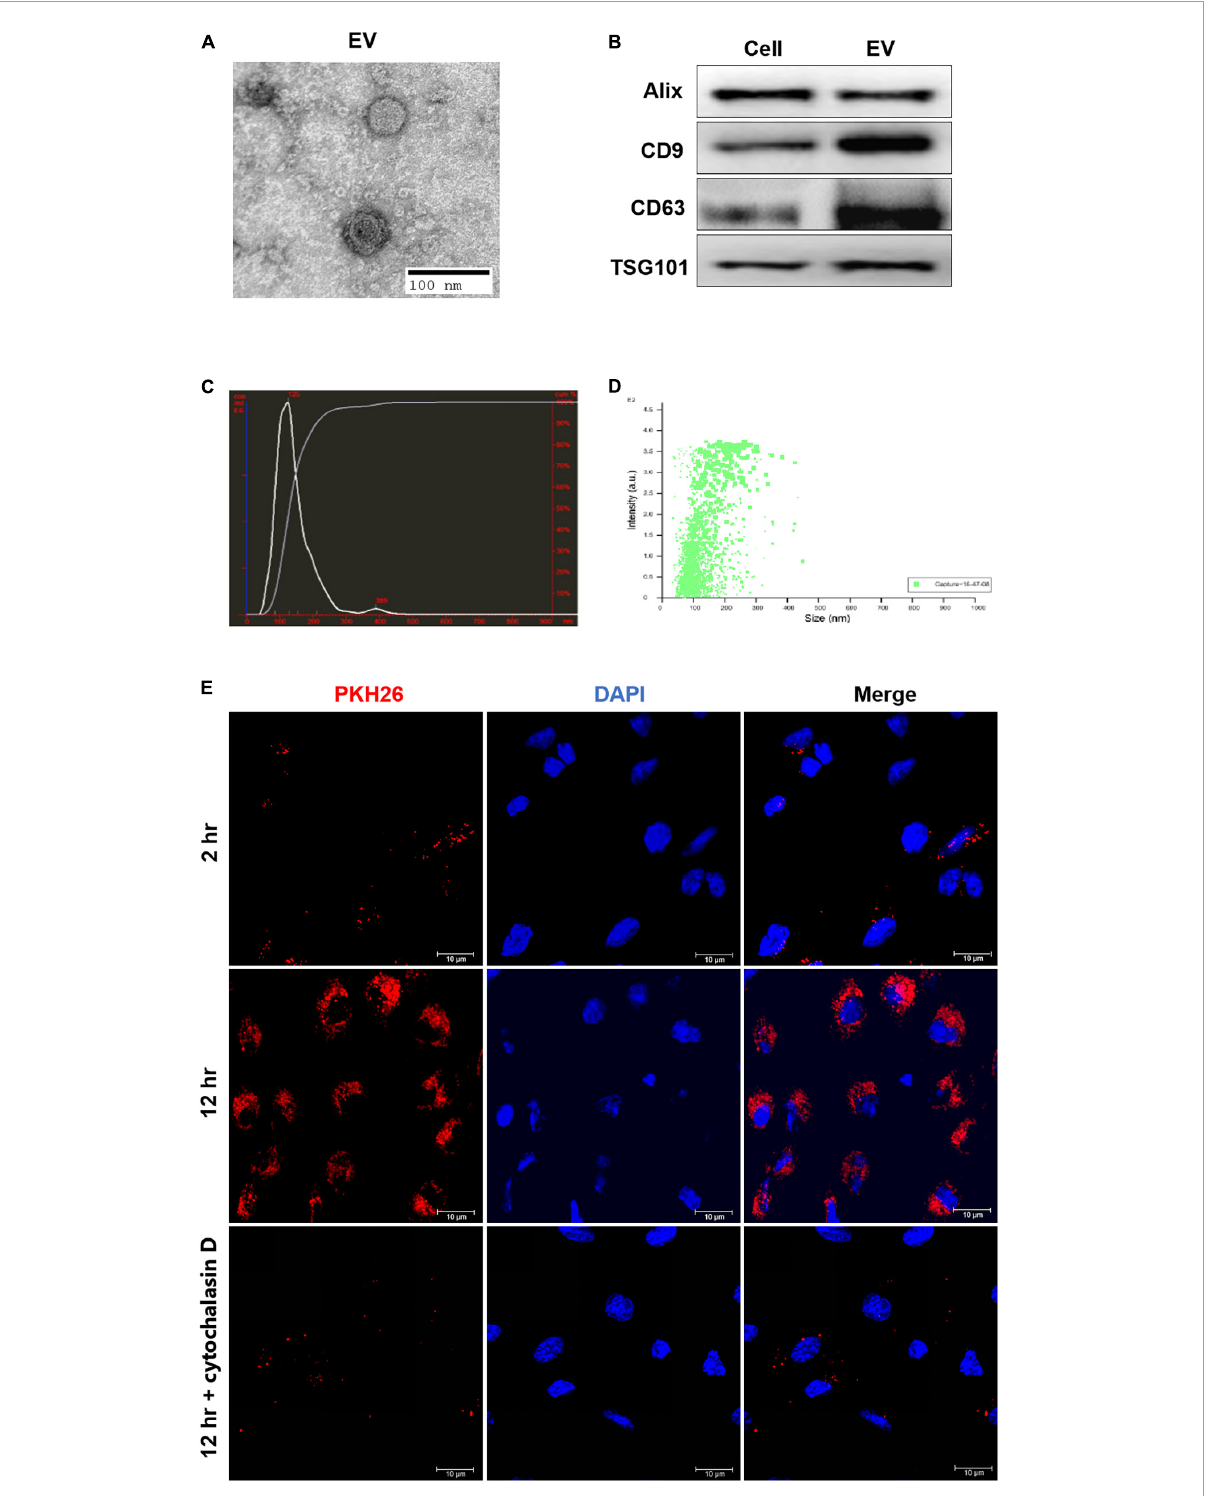
FIGURE2 Isolation and characterization of human-induced pluripotent stem cell- endothelial cell-extracellular vesicle (hiPSC-EC-EV). (A) A representative micrograph of hiPSC-EC-EV visualized by transmission electron microscopy; (B) Relative expression levels of Alix, CD9, CD63, and TSG101 proteins in hiPSC-ECs and hiPSC-EC-EV, as revealed by Western blotting; (C,D) The hiPSC-EC-EV particle size distribution as measured and analyzed by NanoSight; (E) Representative confocal microscopy images of HUVECs exposed for either 2 or 12 h to PKH26-labeled hiPSC-EC-EVs with or without cytochalasin D treatment. The nuclei were counterstained with